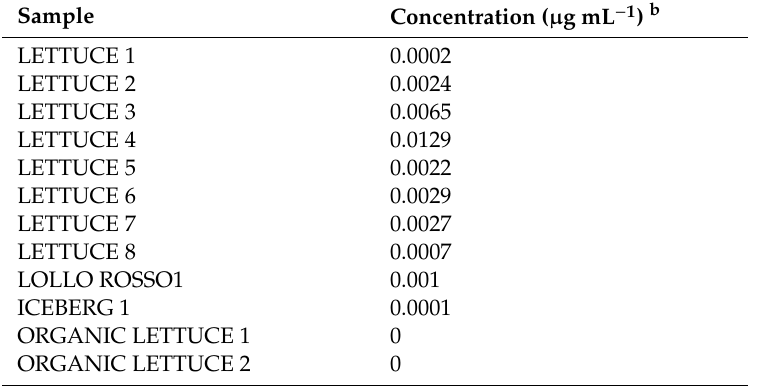
Table 1. Results of lettuce extracts obtaining from a market and analyzed by GC/MS a .